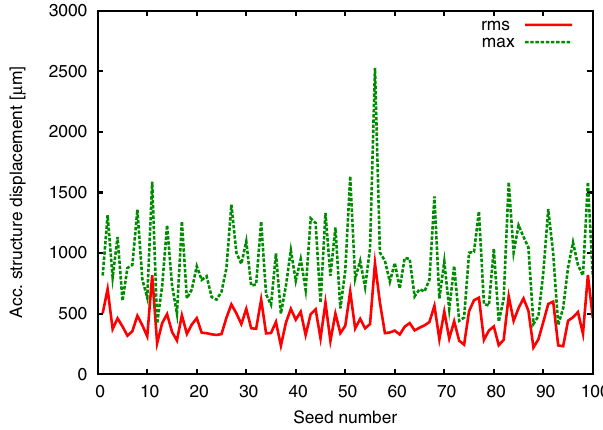
FIG. 5. Root-mean-square and maximum vertical displace- ment of ten accelerating structures used for CLIC emittance tuning. The results for 100 random machines are presented. The displacements should not be larger than a few tens of (cid:1) m